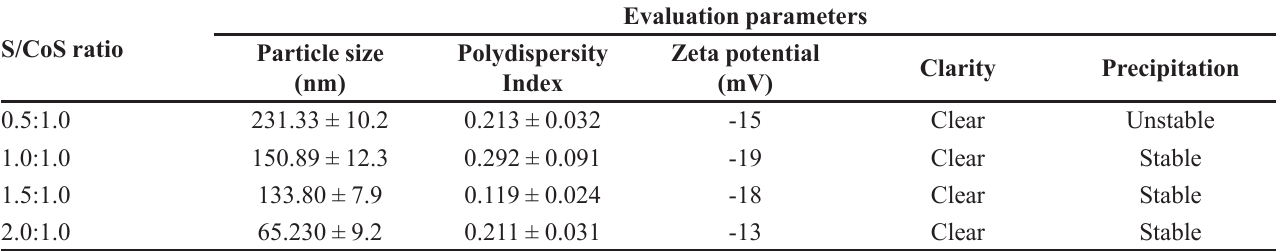
TABLE III - Effect of surfactant to co-surfactant ratios on particle size, polysdispersity index, zeta potential, clarity and precipitation